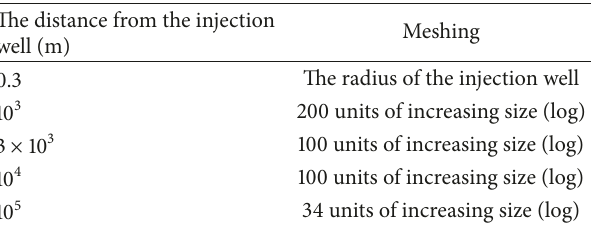
Table 5: 2D radial meshing